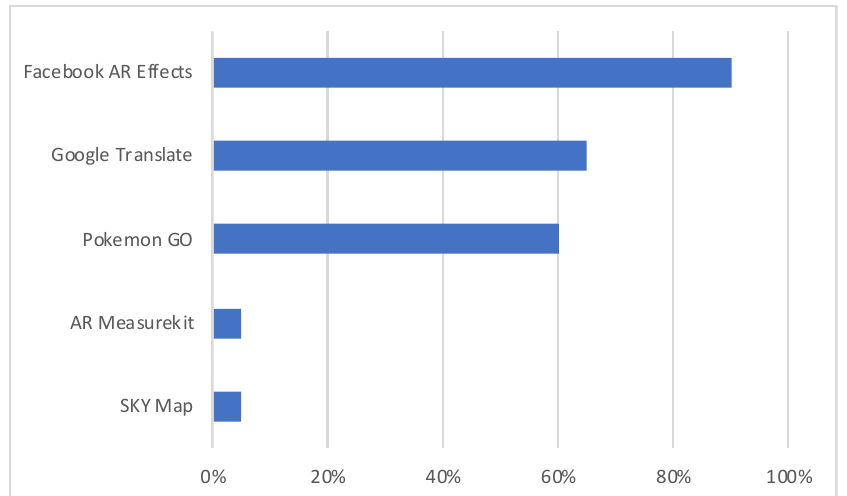
Figure 7. AR apps used by participants.